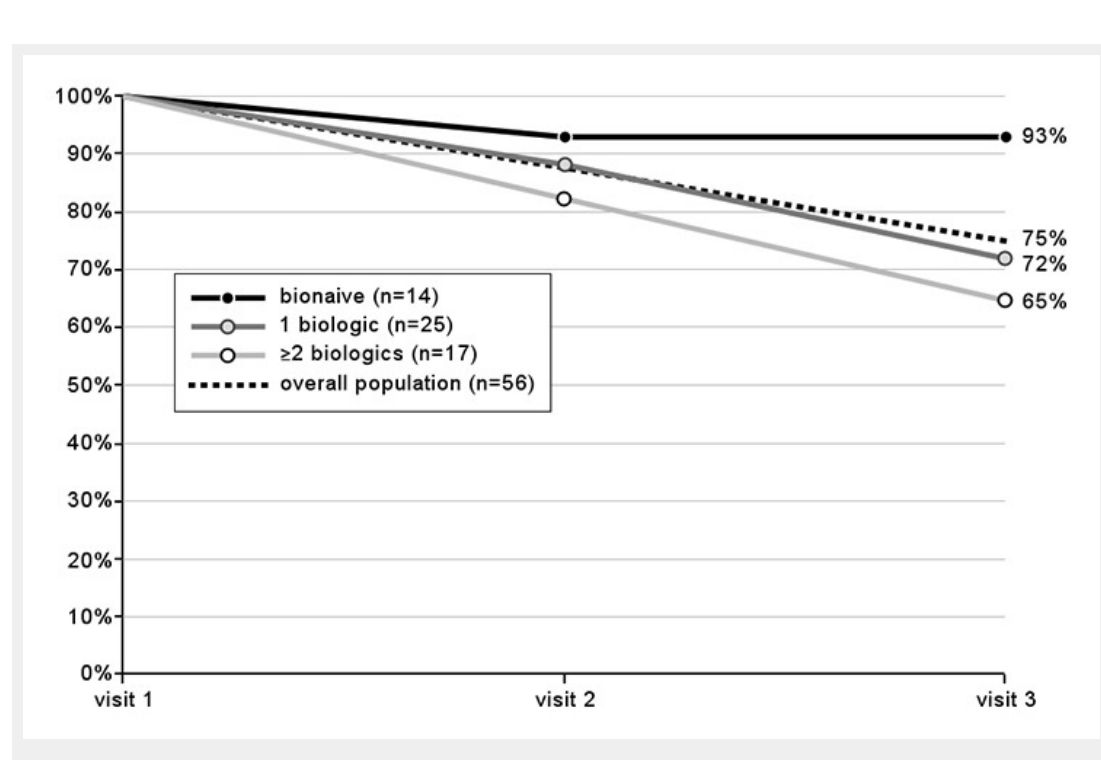
Drug retention over time: percentages of patients still on treatment at visits 2 and 3 (numbers in brackets indicate the population size at visit 1).